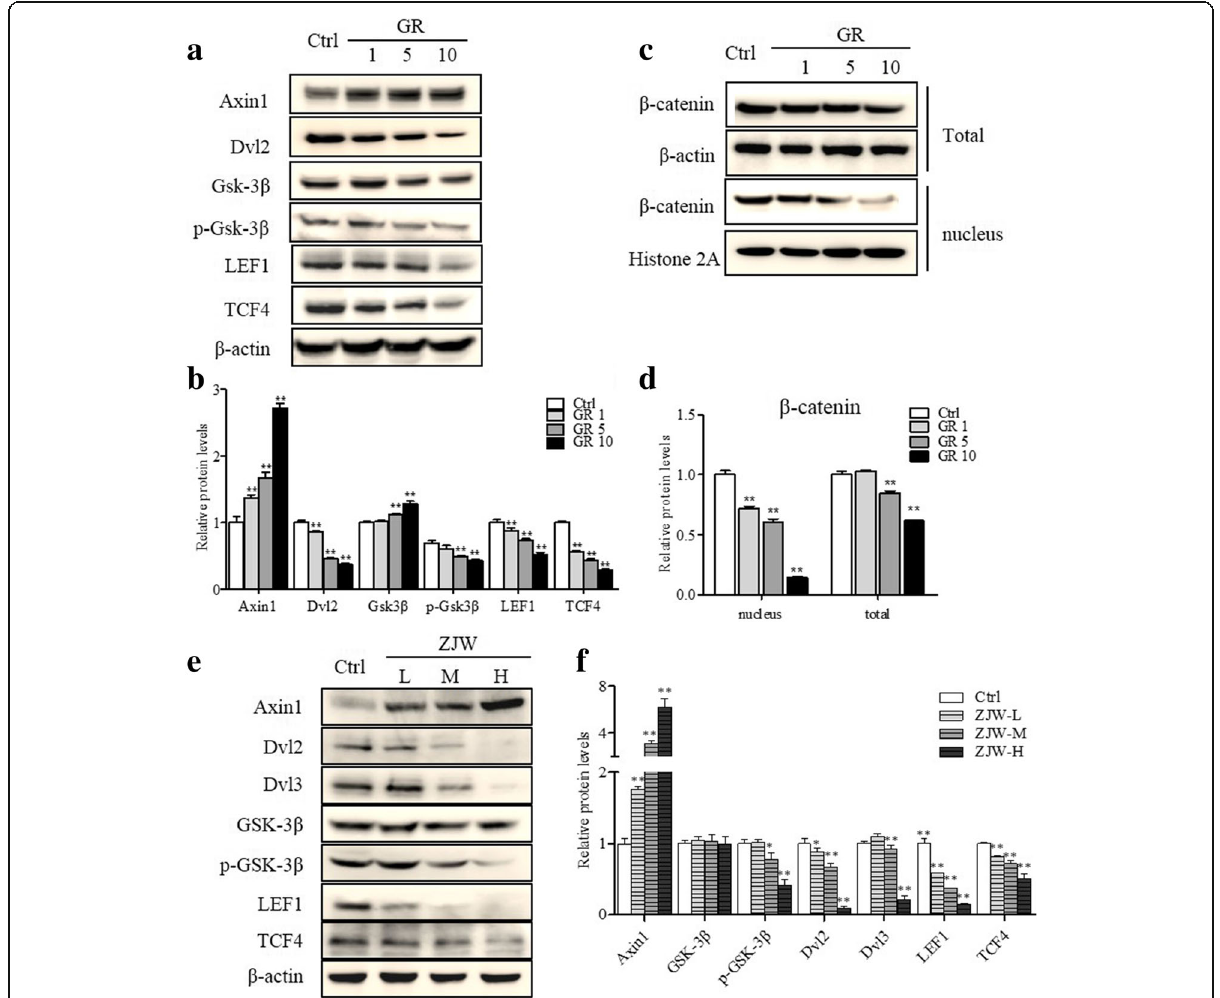
Fig. 5 Effect of GR or ZJW treatment on the Wnt/ β -catenin signaling pathway. a SW403 cells were treated with GR (1, 5, and 10 μ mol/L, respectively) for 24 h. Representative western blots of Axin1, Dvl2, Dvl3, GSK-3 β , LEF1, and TCF4 were shown. b Semi-quantification data of the Western blot relative to β -actin. c Western blotting of β -catenin in total cell lysate and nucleus in SW403 cells treated as ( a ). d The corresponding semi-quantification data of the Western blot relative to histone 2A. e SW403 cells were treated with ZJW-L, ZJW-M and ZJW-H for 24 h. Representative western blots for Axin1, Dvl2, Dvl3, GSK-3 β , serine-phosphorylated-GSK-3 β , LEF1 and TCF4 in SW403 cells were shown. f The semi-quantification data of the Western blot relative to β -actin. All values are shown as mean±SD of three separate experiments, and significant values are indicated with asterisks (* P <0.05, ** P < 0.01 vs.